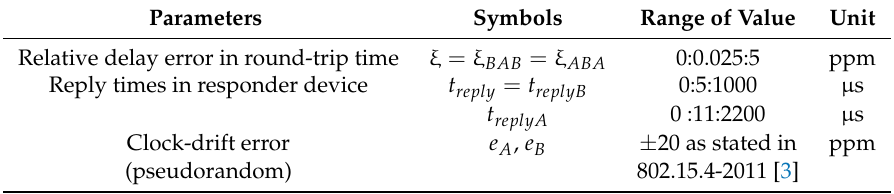
Table 2. Sample Values used in Numerical Simulations ( c (cid:13) 2018 IEEE. Reprinted with permission).